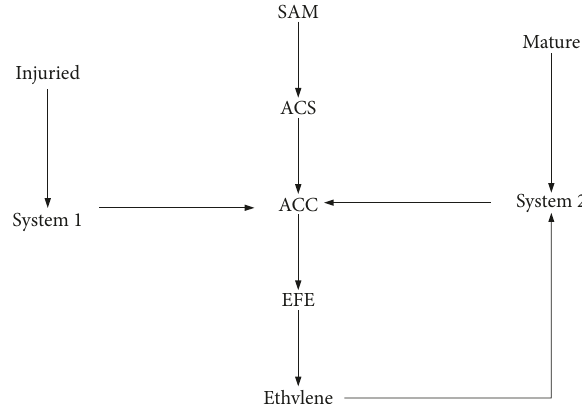
Figure 6: Ethylene biosynthesis and its key